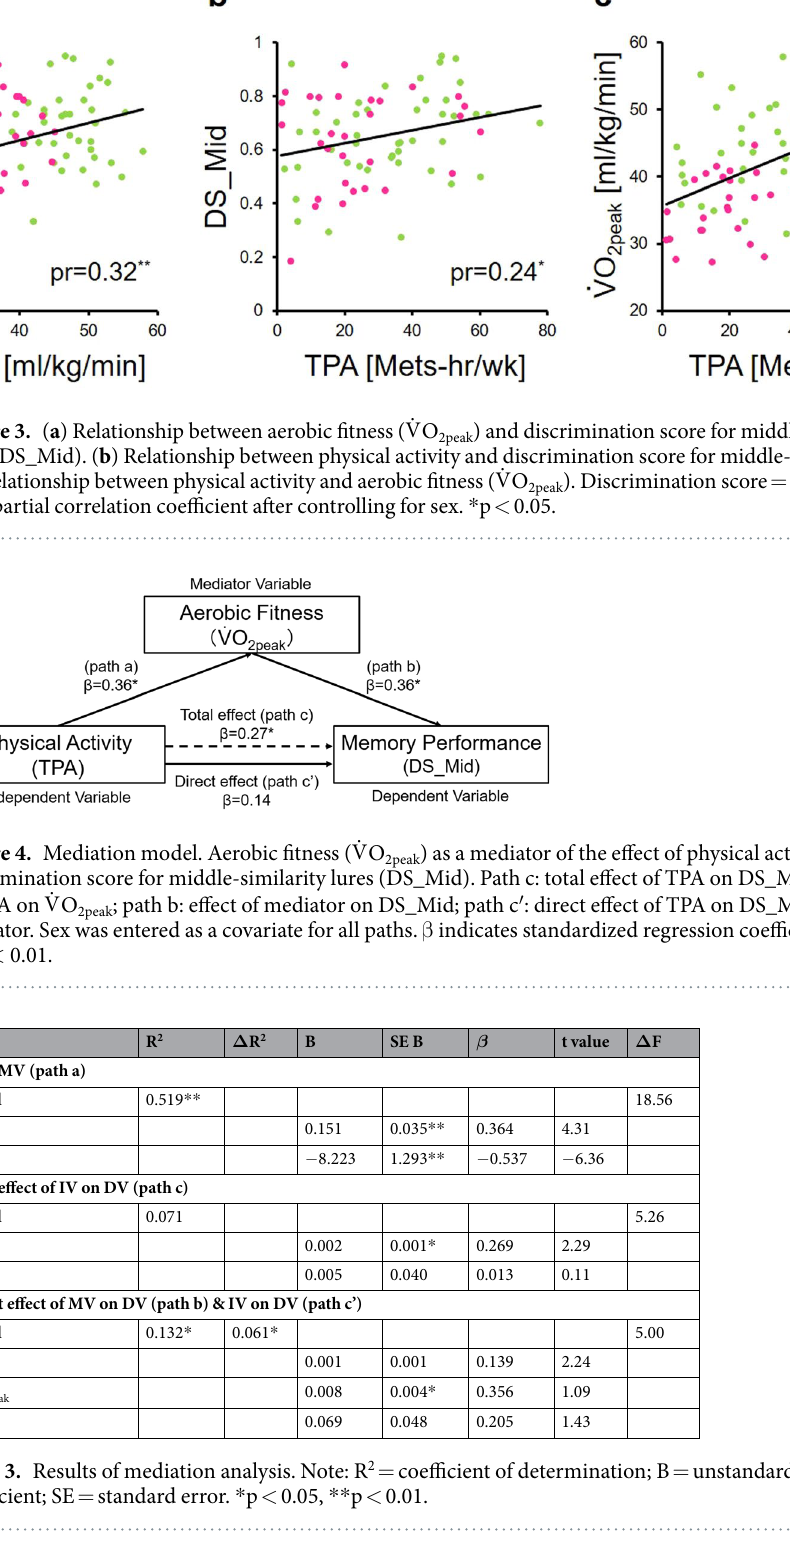
0.13, 95% CI: 0.023 to 0.278), indicating significant mediation. These results further confirm the mediation effect between physical activity and discrimination performance is mediated by aerobic fitness levels.